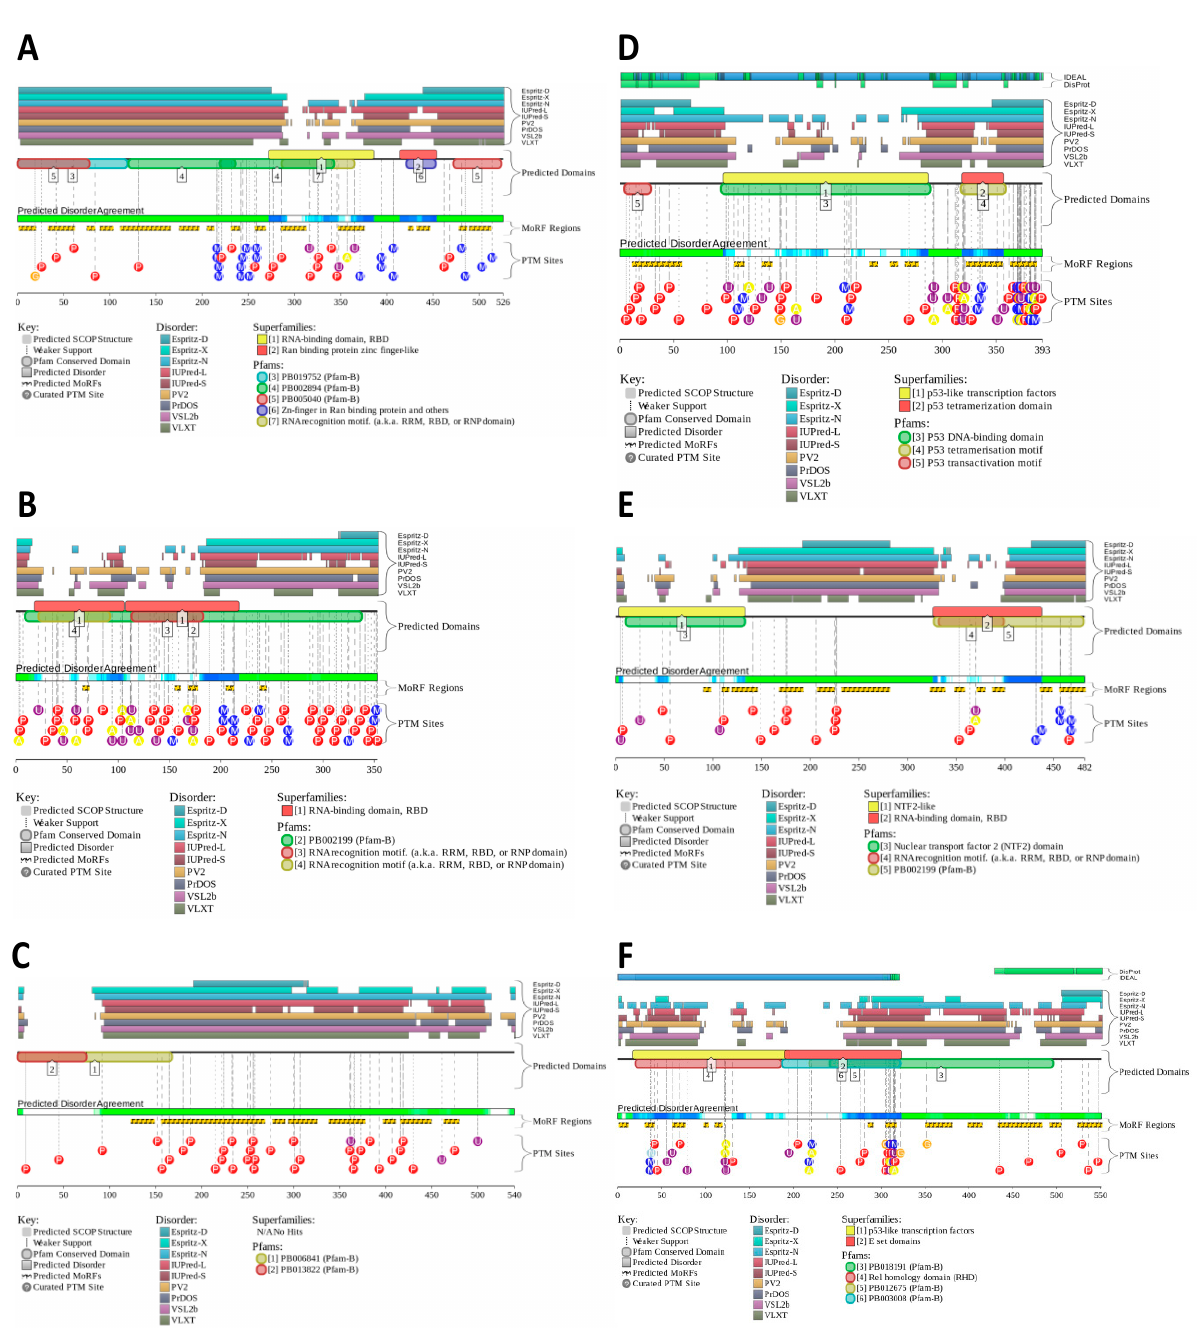
Figure 4. Functional disorder profiles generated for FUS ( A ), hnRNPA2 ( B ), MAVS ( C ), p53 ( D ), G3BP2 ( E ), and p65 ( F ) by the D 2 P 2 platform, which is a database of predicted disorder for proteins from completely sequenced genomes (https://d2p2.pro/) (last accessed on 09 December 2022). Here, the outputs of IUPred, PONDR ® VLXT, PrDOS, PONDR ® VSL2, PV2, and ESpritz are used to show disorder predispositions of query proteins by differently colored bars. Consensus between these nine disorder predictors is shown by the blue-green-white bar, whereas location of various PTMs is shown by differently colored circles. D 2 P 2 also shows positions of conserved functional SCOP domains as predicted by the SUPERFAMILY predictor. Positions of these functional domains are shown below the outputs of the nine disorder predictors. Functional disorder profile also includes information on the location of predicted disorder-based binding sites (MoRF regions) identified by the ANCHOR algorithm and various PTMs assigned using the outputs of PhosphoSitePlus.